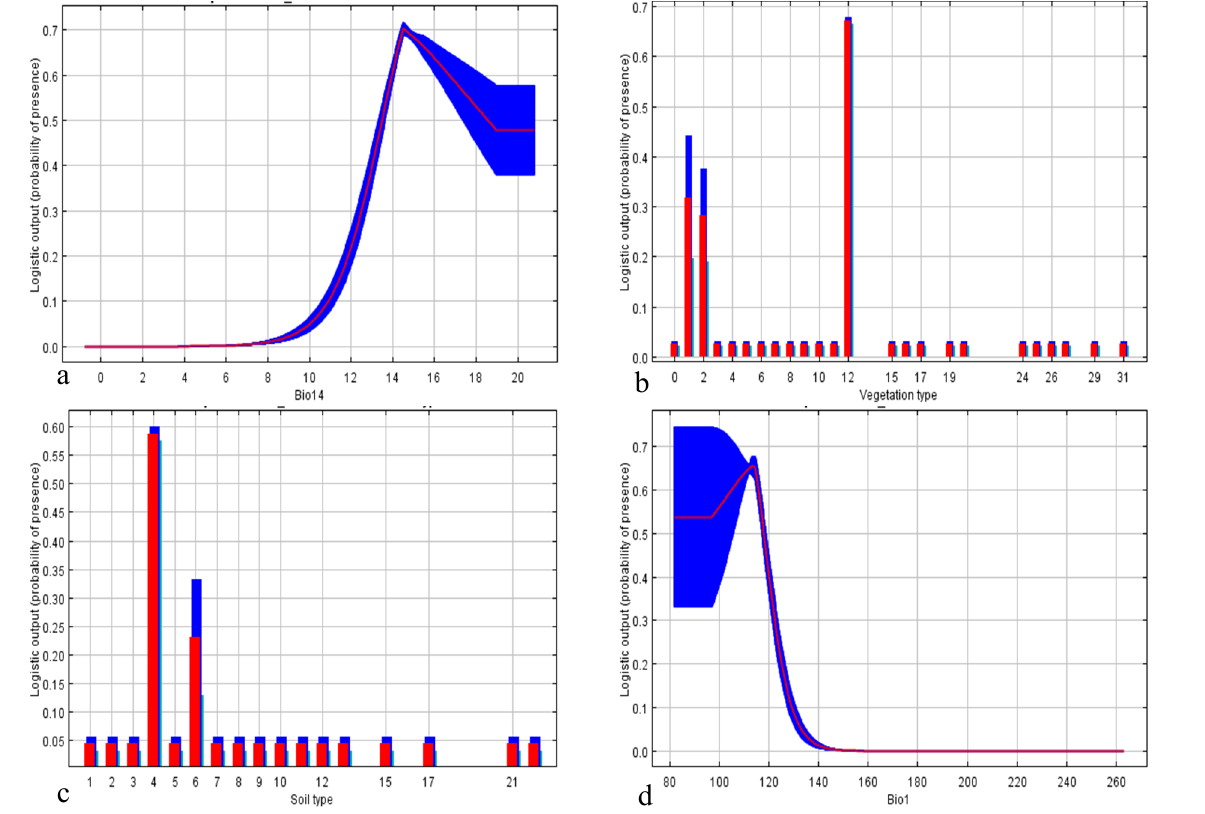
Figure 5. Response curves of the variables that most contributed to explain the potential distribution of Picea chihuahuana Martínez in Mexico ( a = minimum temperature of the coldest month (Bio14), b = vegetation type, c soils type =, d = precipitation of the driest month (Bio1)): model at state scale.